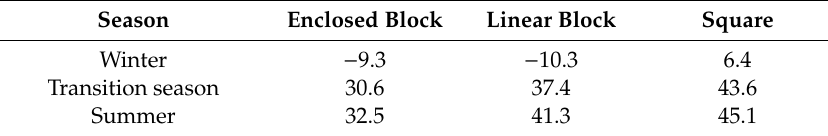
Table 6. Average mean radiation temperature ( ◦ C) of each space form.